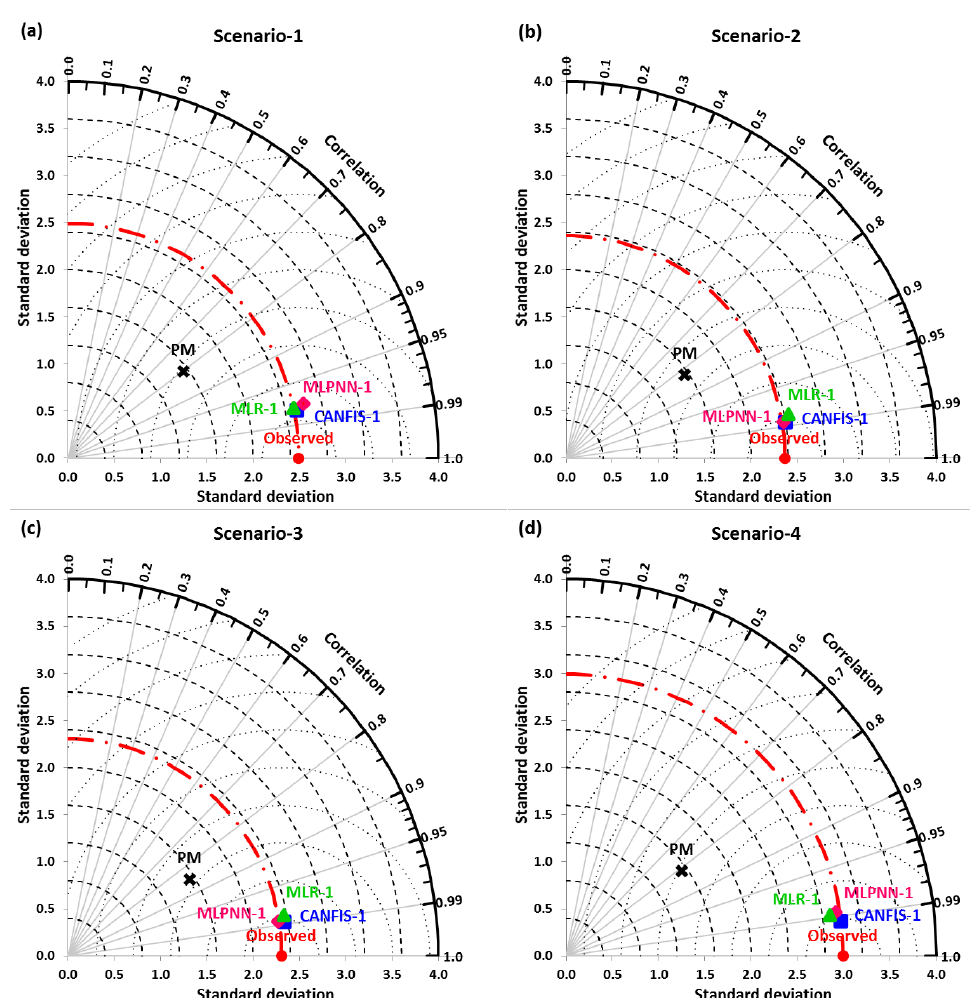
Figure 9. Taylor diagram (TD) of observed and estimated monthly evaporation obtained by the CANFIS-1, MLPNN-1, MLR-1, and PM models in ( a ) scenario-1, ( b ) scenario-2, ( c ) scenario-3, and ( d ) scenario-4 during the testing period at Pantnagar station.